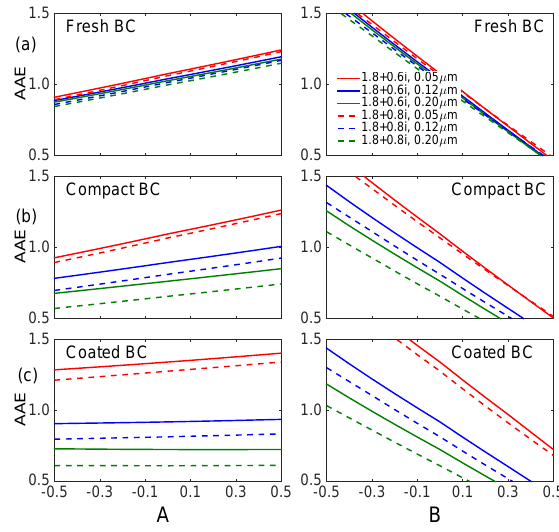
Figure 8. Influence of wavelength-dependent refractive indices